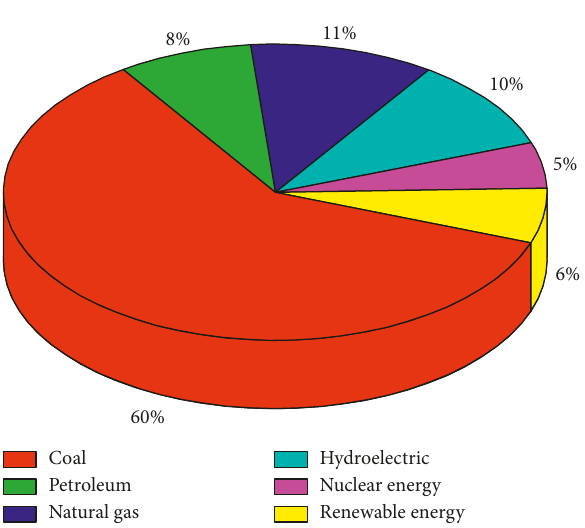
Figure 2: Energy consumption structure of China in